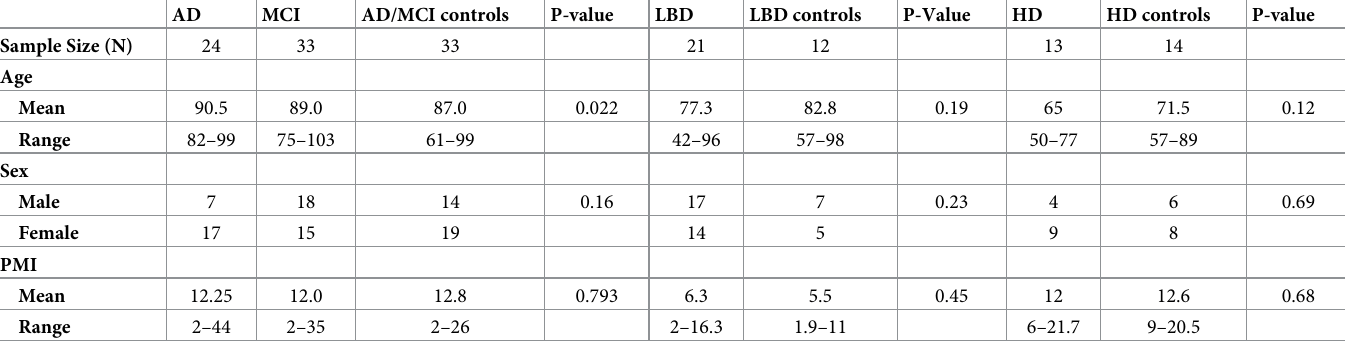
Table 1. Comparison of demographic characteristics of AD, LBD, HD patients and non-demented controls from the Mayo Clinic Study of Aging, the Pacific Udall Center, the Alzheimer’s Disease Research Center, and the Adult Changes in Thought Study, the NIH NeuroBioBank, and the New York brain bank.